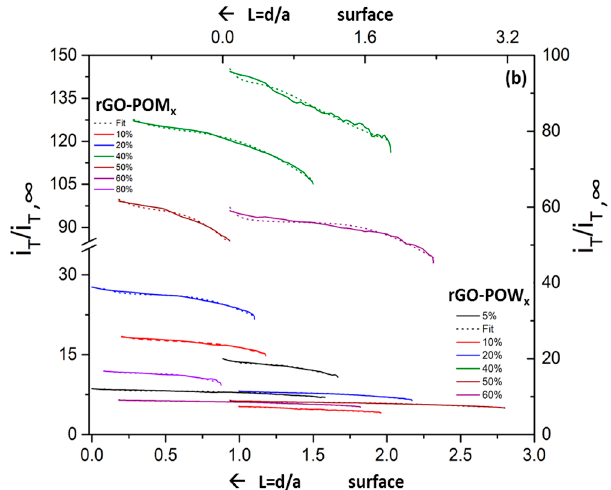
Figure 5. (Color online). Probe approach curves for rGO–POM x and rGO–POW x series indicative of semiconducting (or insulating) behavior at solid/liquid interface with redox mediator 10 µ M FcMeOH (ferrocene methanol) in base electrolyte 0.4 M Na 2 SO 4 with tip V t = +0.5 V and substrate voltage V s = − 0.4 V. The corresponding theoretical fitting is plotted as dash curves.